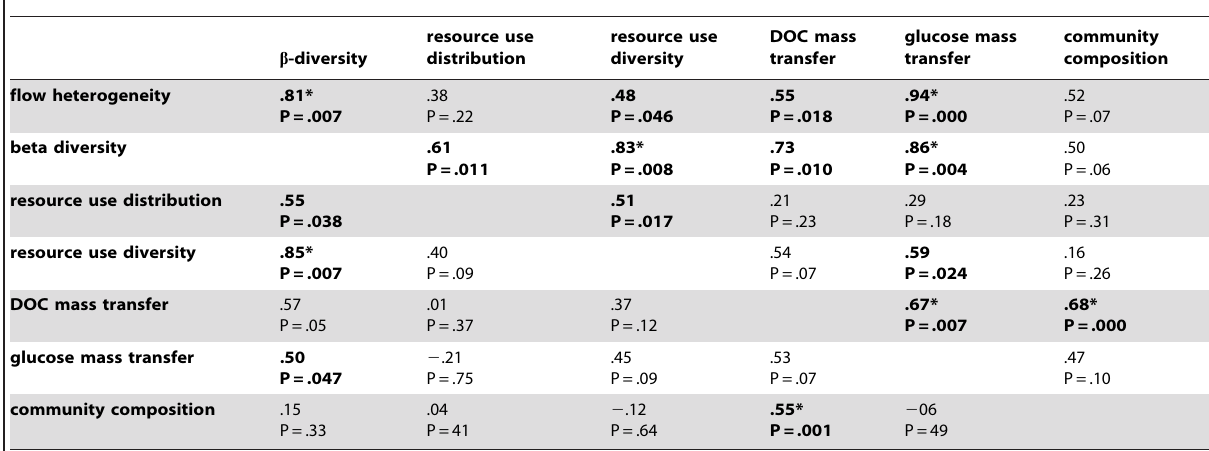
Table 1. Mantel statistics between metavariable dissimilarity